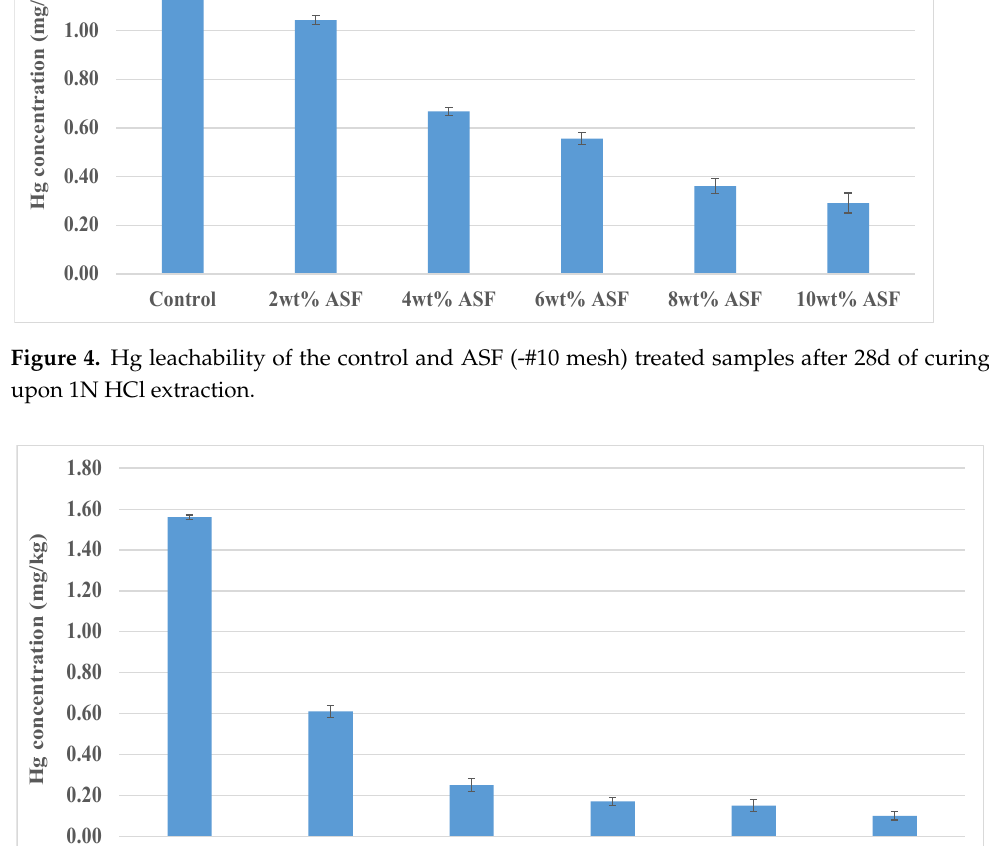
Figure 5. Hg leachability of the control and ASF (-#20 mesh) treated samples after 28d of curing, upon 1N HCl extraction.